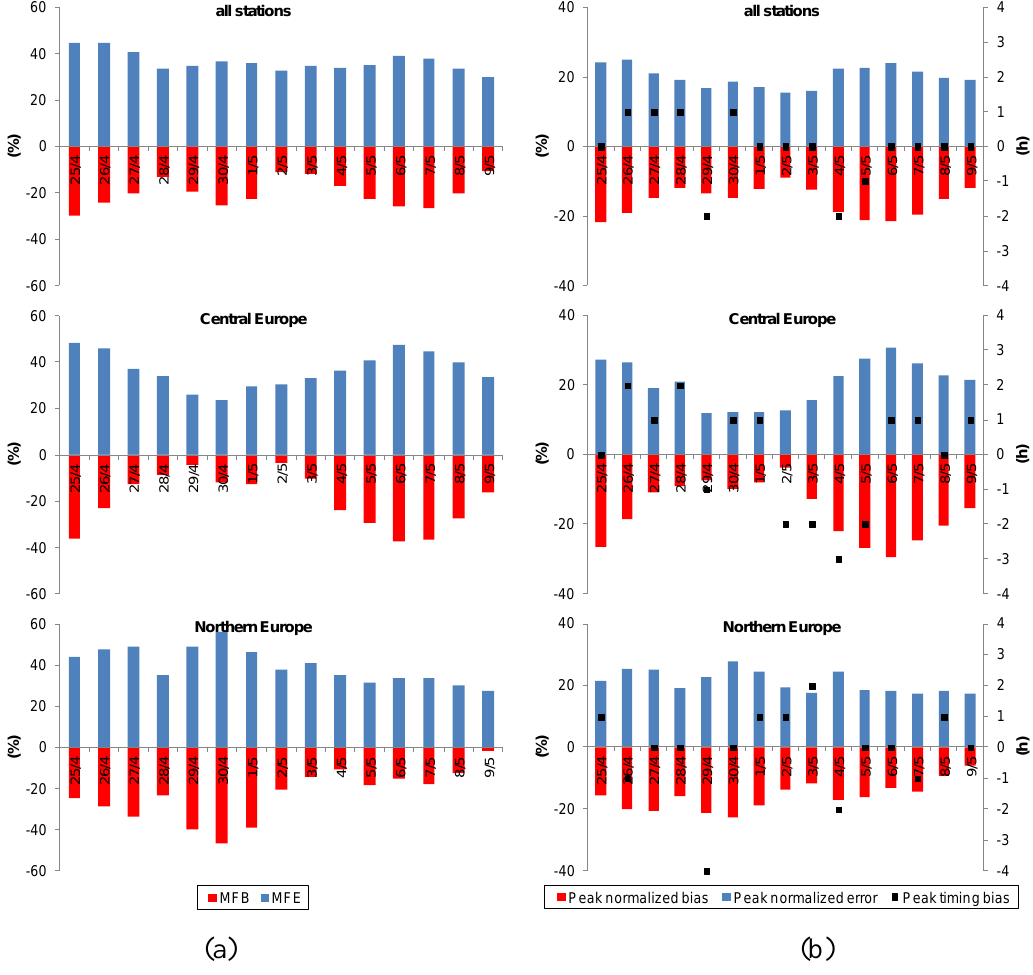
Fig. 8. Daily variation of the (a) MFB and MFE and (b) time-unpaired peak normalized bias, time-unpaired peak normalized error (left axis) and bias in peak timing (right axis) over all stations, and stations of Central and Northern Europe, during the period 25 April–9 May.